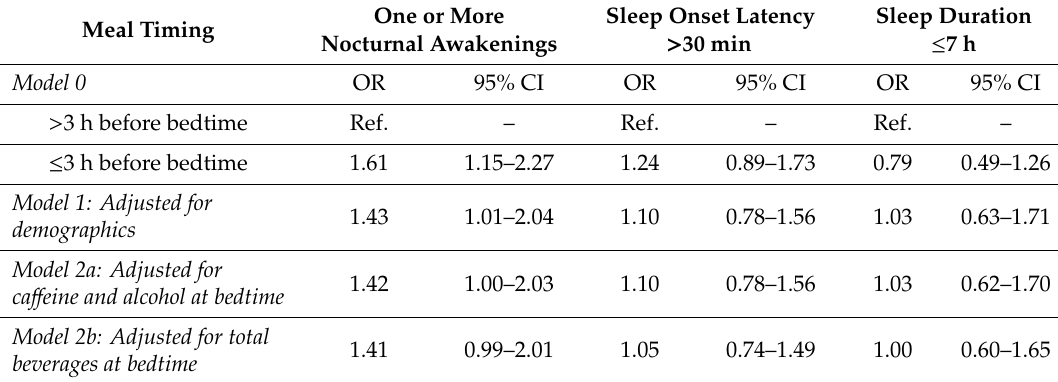
Table A1. Association between meal timing and sleep parameters with and without adjustment for covariates by logistic regression